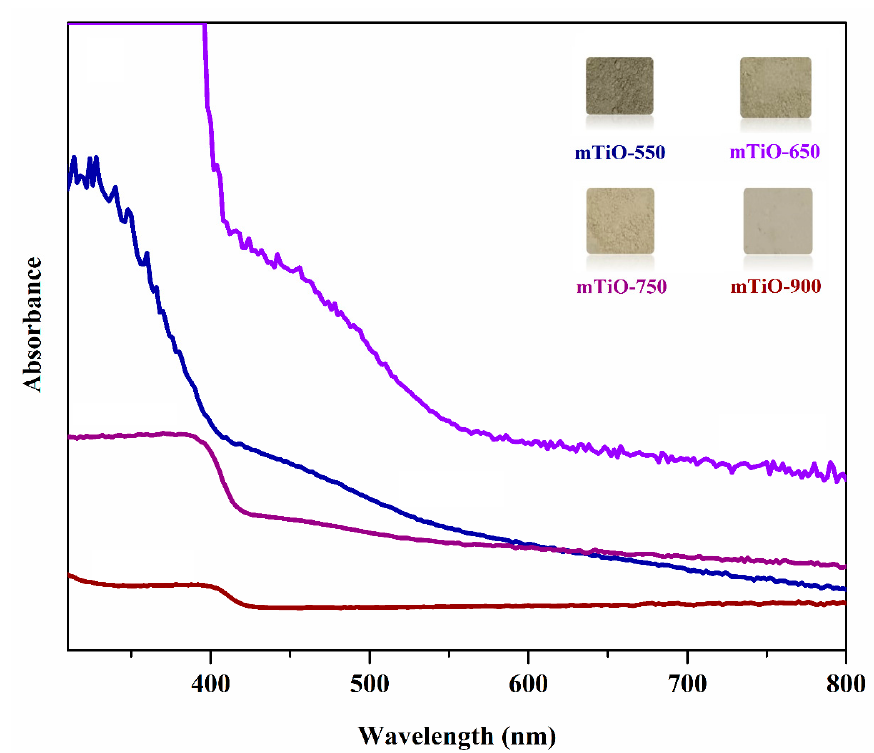
Figure 10. UV–VIS spectra of treated Ti 2 O 3 catalysts.